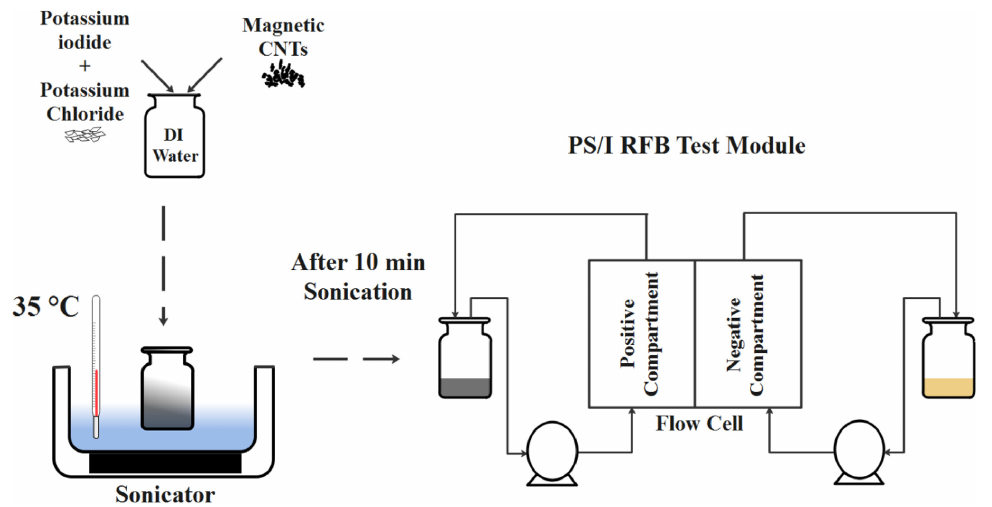
Figure 6. Two-step synthesis step of the magnetic nanofluidic electrolyte and polysulfide/iodide redox flow batteries (PS/I RFB) test system. Adapted with permission from the paper written